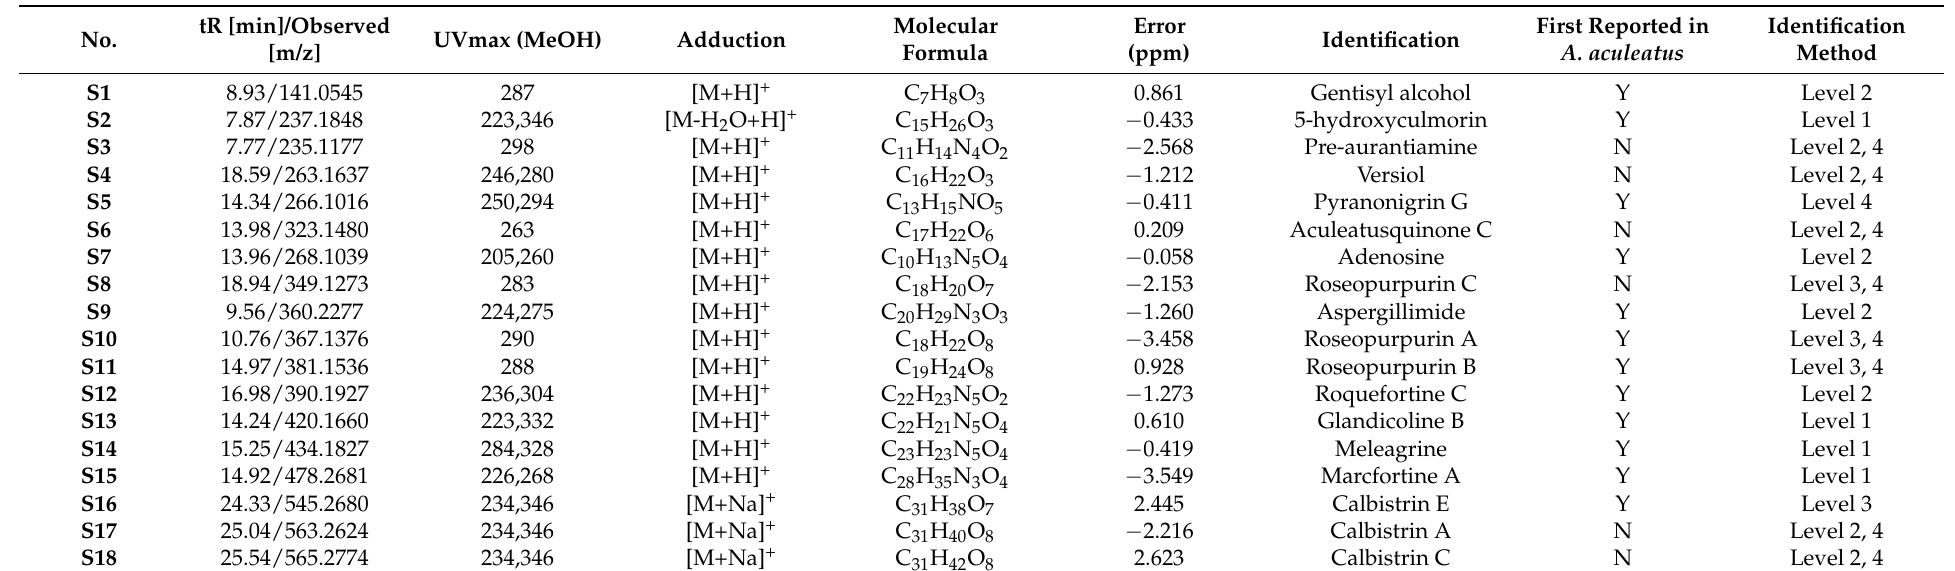
Table 1. List of features newly induced by CER in the